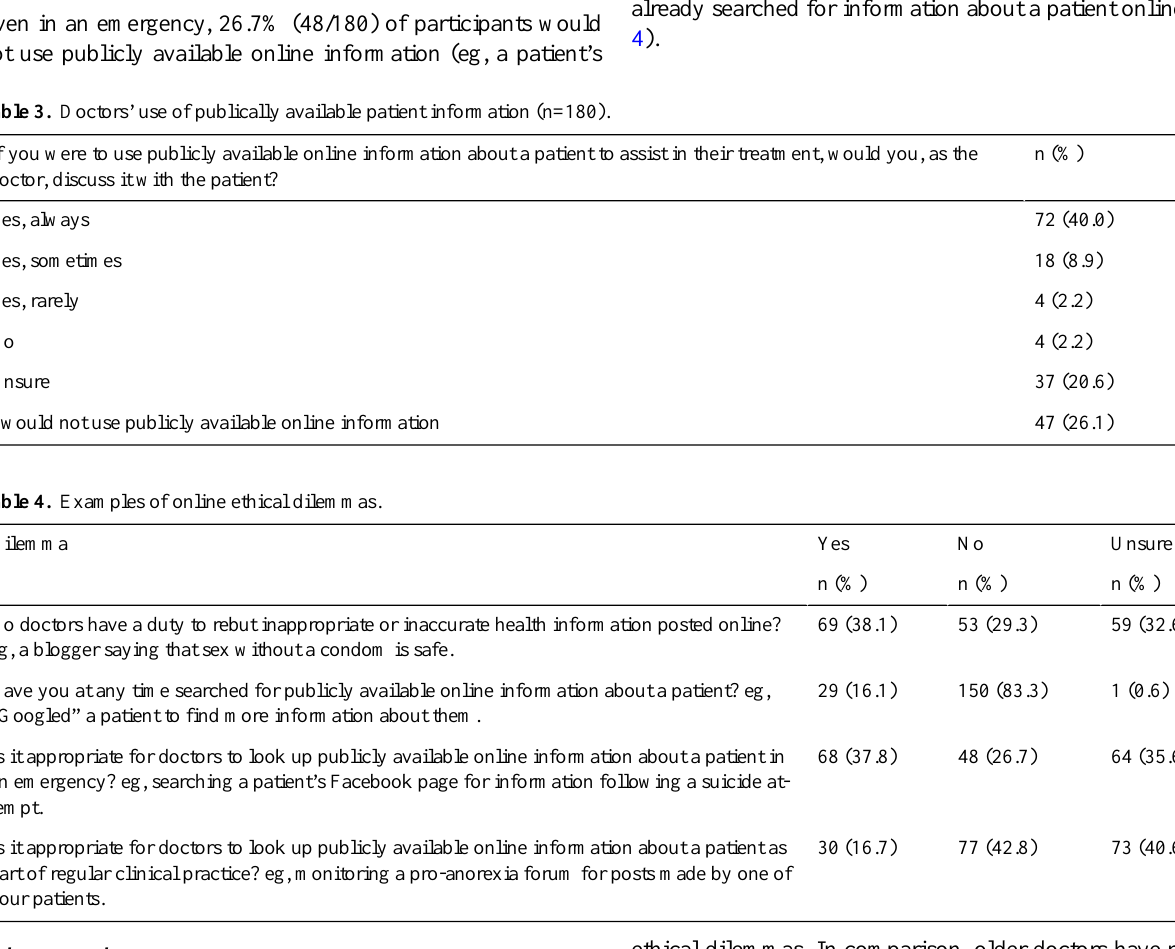
n (%)If you were to use publicly available online information about a patient to assist in their treatment, would you, as the